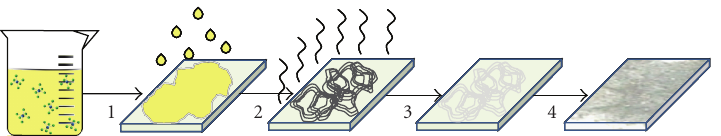
Figure 4: Schematic representation of the steps involved in preparation of Pt thin film in DSSC counter electrodes by means of hexachloroplatinic acid